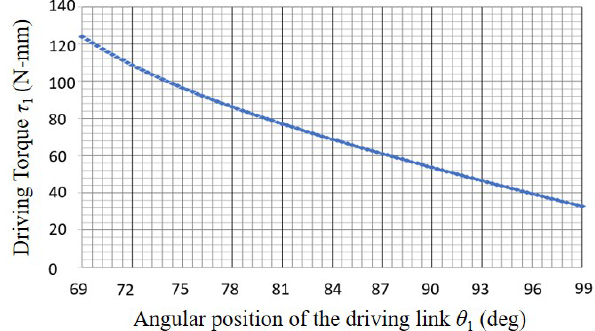
Figure 11. Simulation of driving torque.